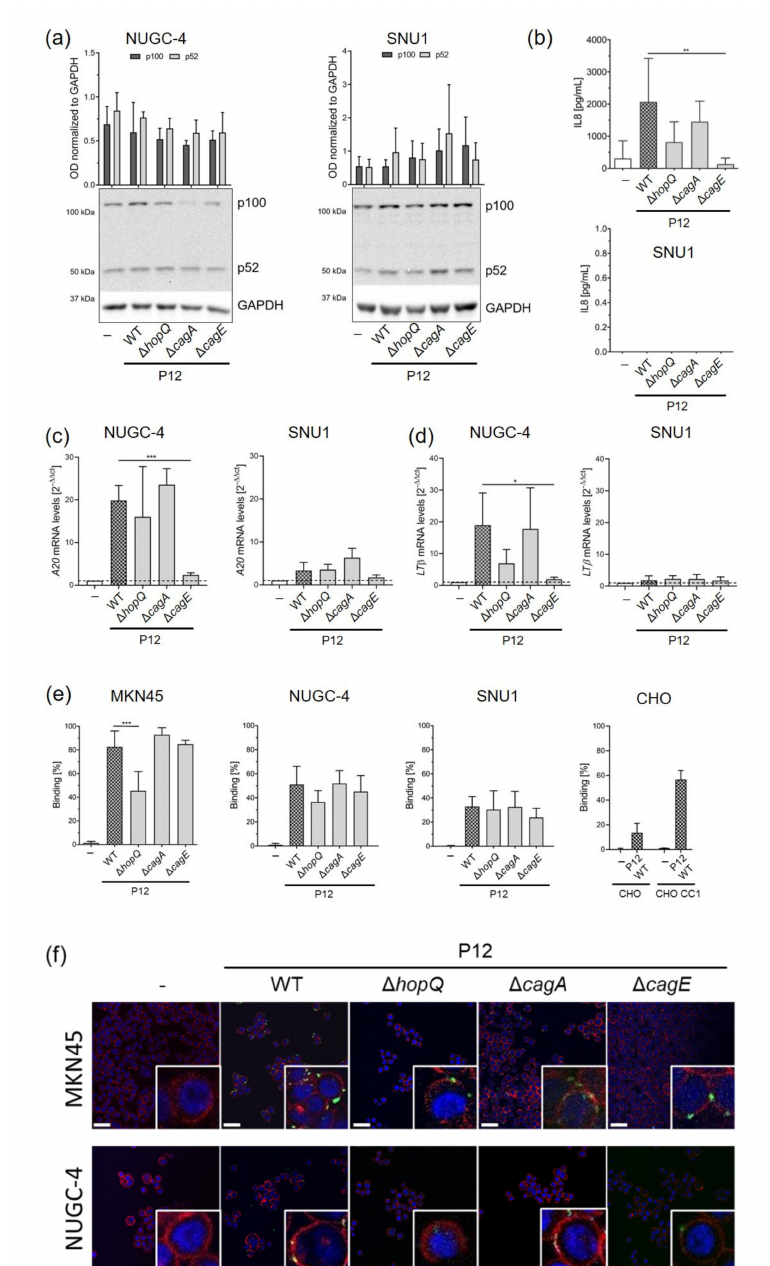
Figure 3. Interaction of HopQ with CEACAM is important for activation of the non-canonical NF- κ B pathway. NUGC-4 and SNU1 cells were infected with P12 wild type H. pylori strain, or isogenic